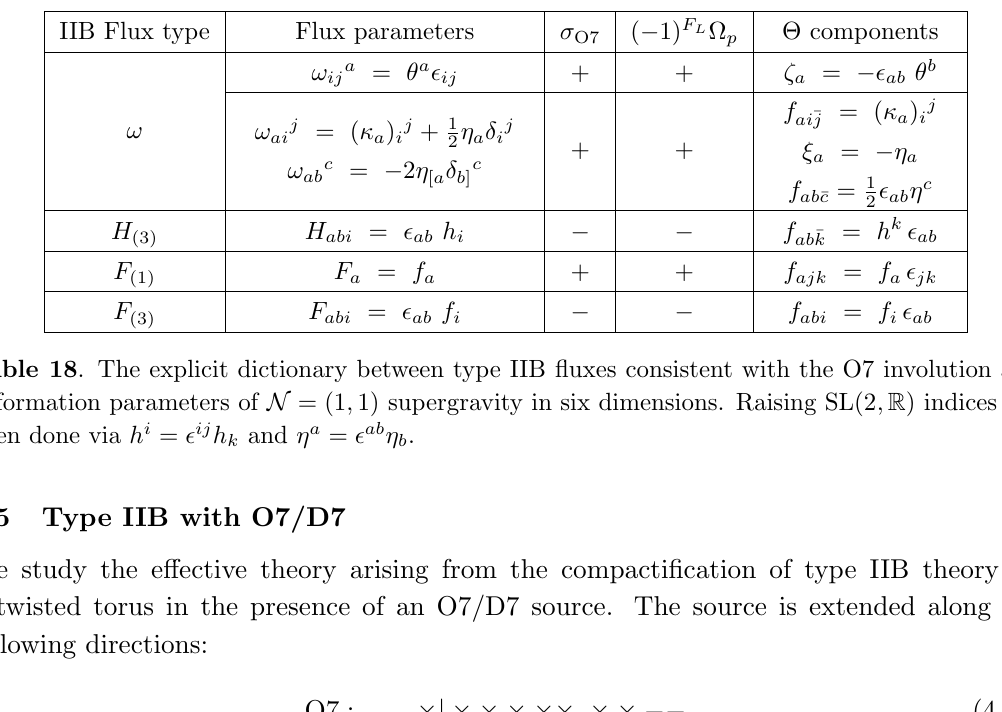
Table 17 . Critical points of the scalar potential induced by the compacti(cid:12)cation of IIB with O5/D5. In this case, we obtain a unique 4-parameter family of solutions, for which a Mkw vacuum is found.